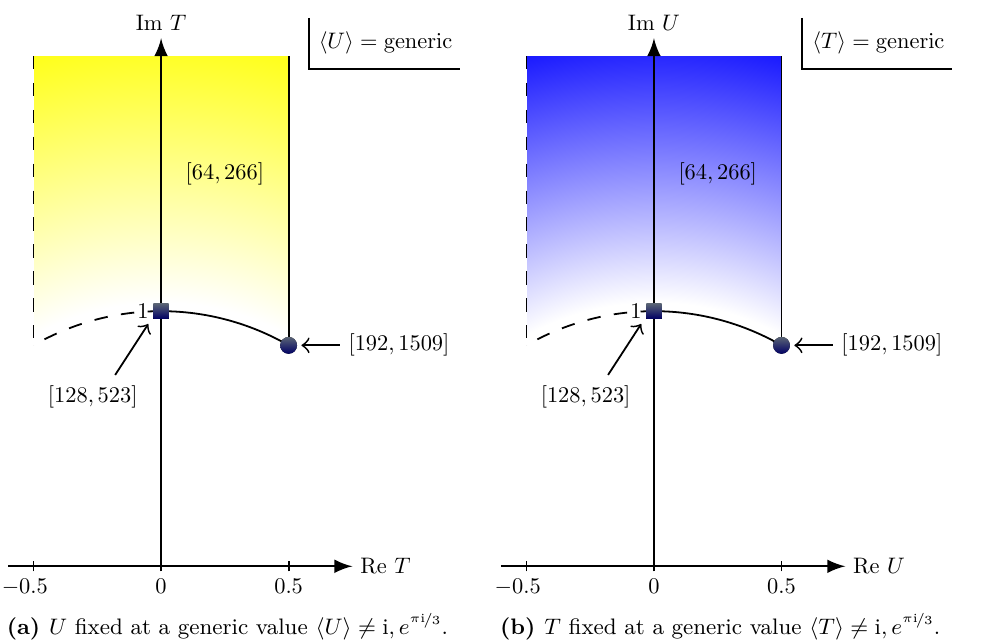
symmetry. (a) 4 ˆ ˆ ˆ C T and K S ↔ C S T ↔